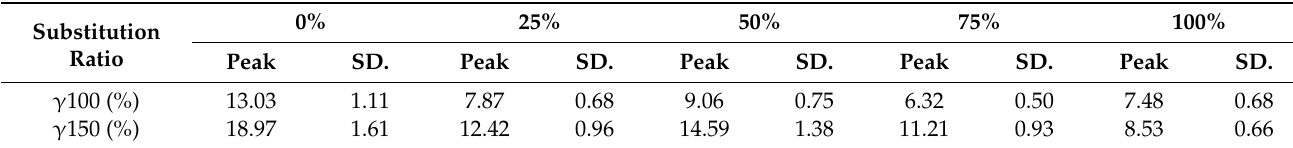
Table 5. Strength size effect of recycled aggregate